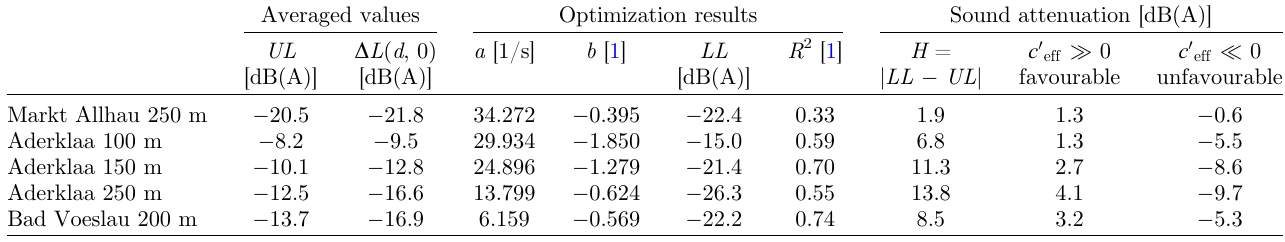
Table 2. Summary of different constants (derived from measurement results) for the calculation of the S-shaped function. Sound attenuation without meteorological in fl uences D L ( d , 0), because of meteorological in fl uences H and for favourable ( c 0 eff > 0) and unfavourable ð c 0 < 0) sound propagation. eff